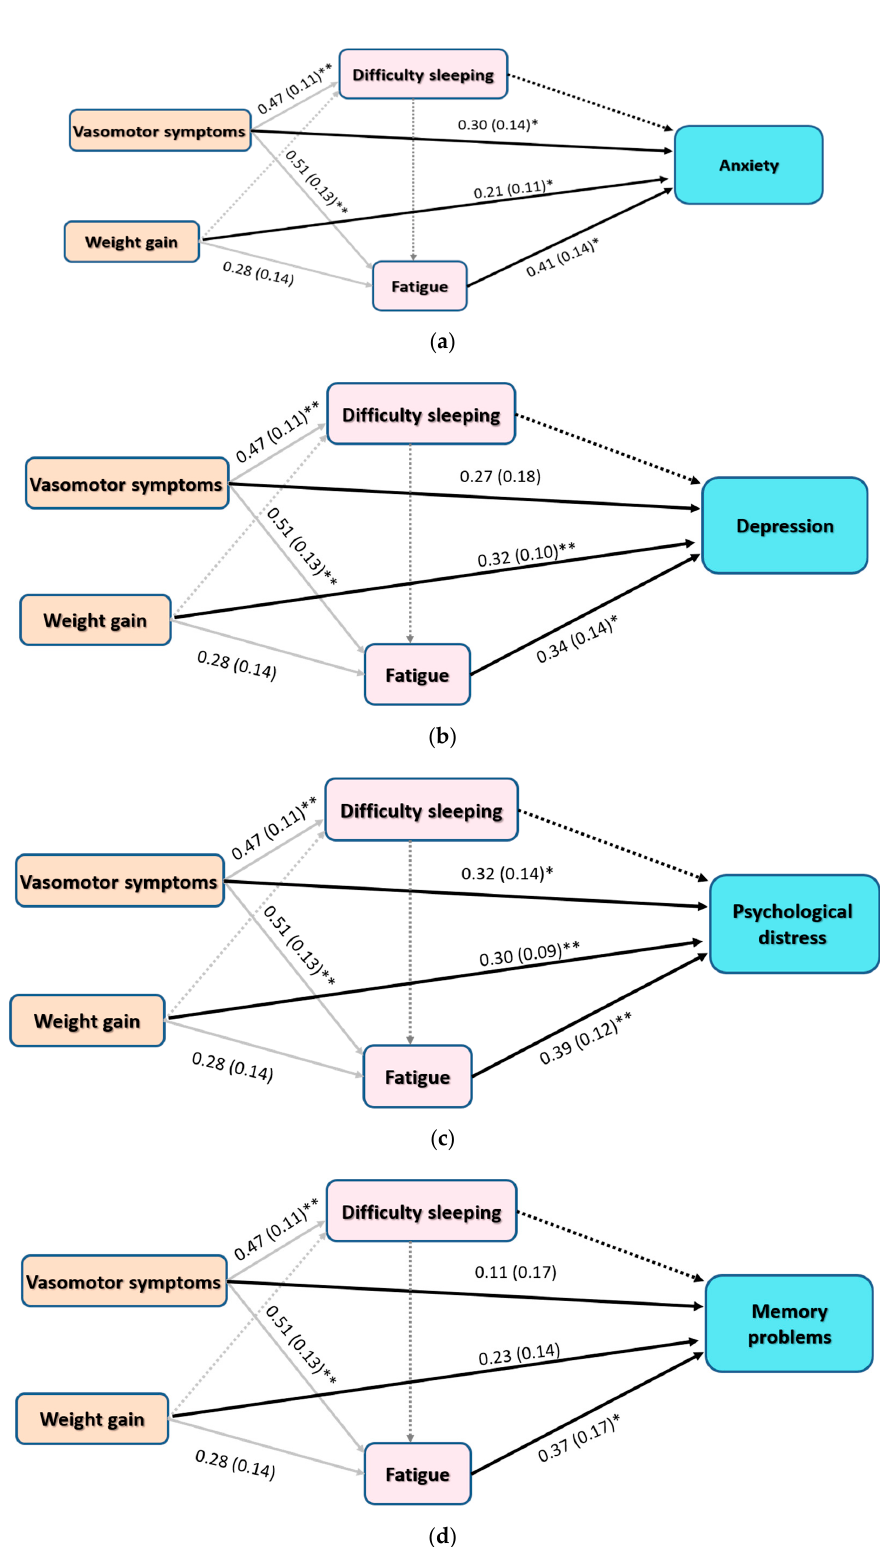
Figure 3. Results of trimmed path analysis models with standardized beta weights, standard errors, and significance values depicting relationships of vasomotor symptoms, weight gain, difficulty sleeping, and fatigue with symptoms of anxiety (Panel a ), depression (Panel b ), psychological distress (Panel c ), and memory problems (Panel d ) among menopausal women. * p < 0.05, ** p < 0.01. Dotted lines represent trimmed